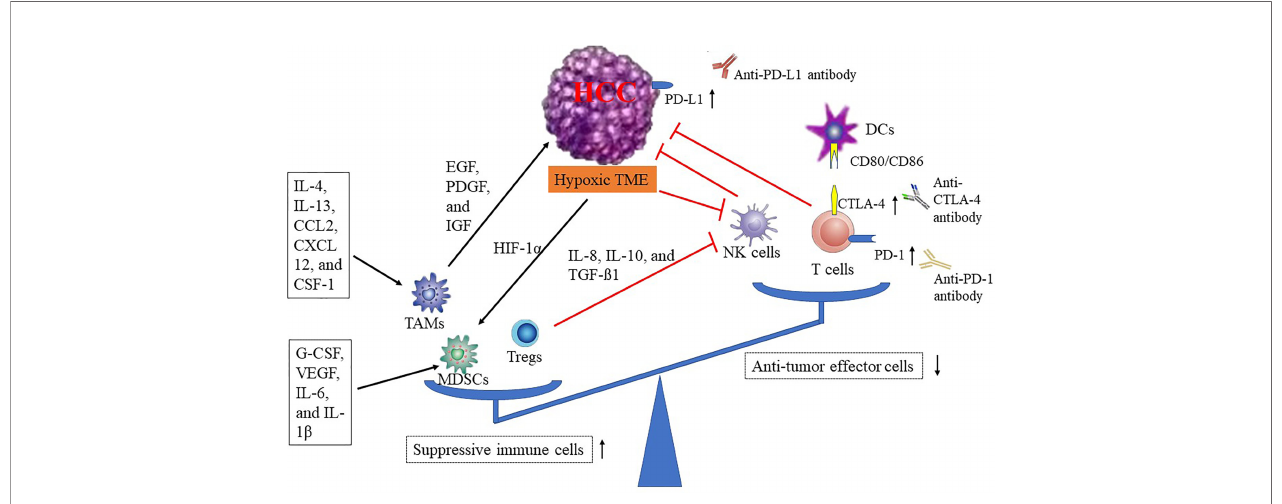
FIGURE 1 | Mechanisms of HCC immune tolerance. CCL-2, C-C motif chemokine ligand 2; CTLA-4, cytotoxic T-lymphocyte antigen-4; CSF-1, colony-stimulating factor; DCs, dendritic cells; CXCL-12, C-X-C motif chemokine ligand 12; EGF, epidermal growth factor; HCC, hepatocellular carcinoma; HIF-1 a , hypoxia-inducible factor 1 a ; IGF, insulin-like growth factor; IL, interleukin; NK cells, natural killer cells; MDSCs, myeloid-derived suppressor cells; PD-1, programmed death-1; PD-L1, programmed death-ligand 1; PDGF, platelet-derived growth factor; TMAs, tumor-associated macrophage; TME, tumor microenvironment; Tregs, regulatory T cell; VEGF, vascular endothelial growth